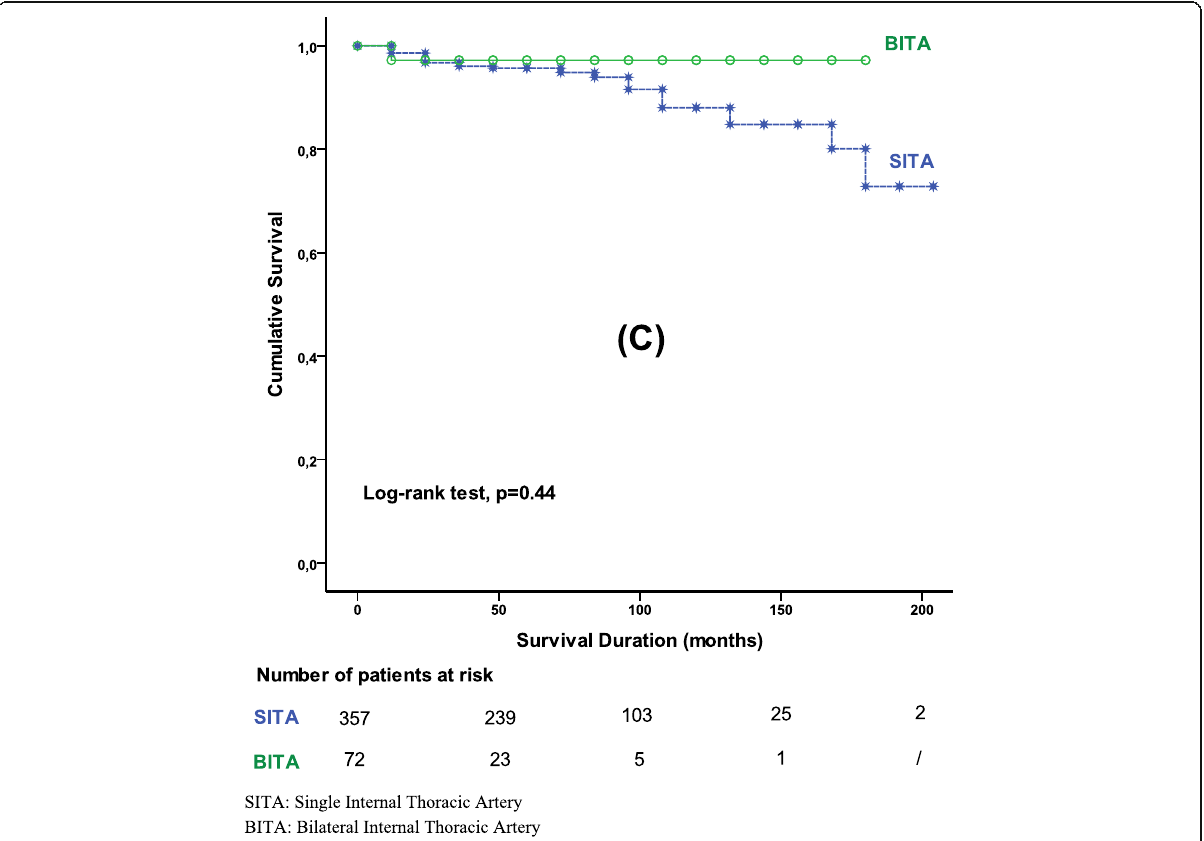
Fig. 3 Kaplan-Meier survival curve (C) for the whole cohort with comparison between patients who received bilateral internal thoracic artery use ( n = 88, 16.6%) and single internal thoracic artery ( n = 441, 83.4%). SITA: single internal thoracic artery. BITA: bilateral internal thoracic